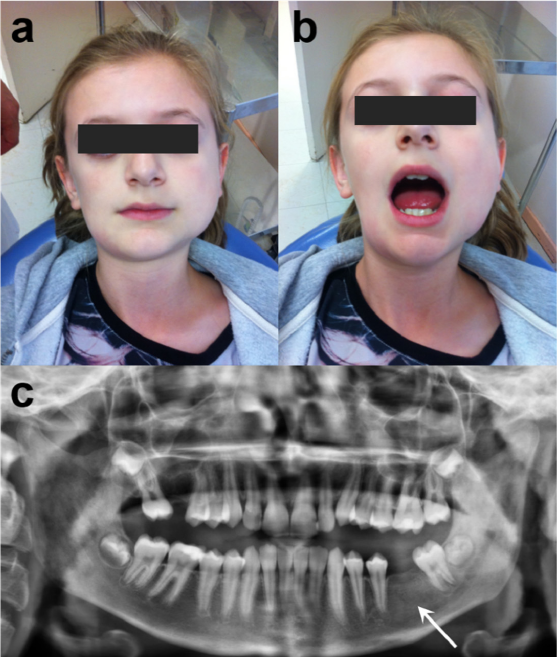
Figure 1. Initial presentation of patient: ( a ) frontal view of the patient, ( b ) limited mouth opening of 25 mm inter-incisor distance, ( c ) panoramic radiograph showing diffuse radiopacity in the left mandibular bone (white arrow).